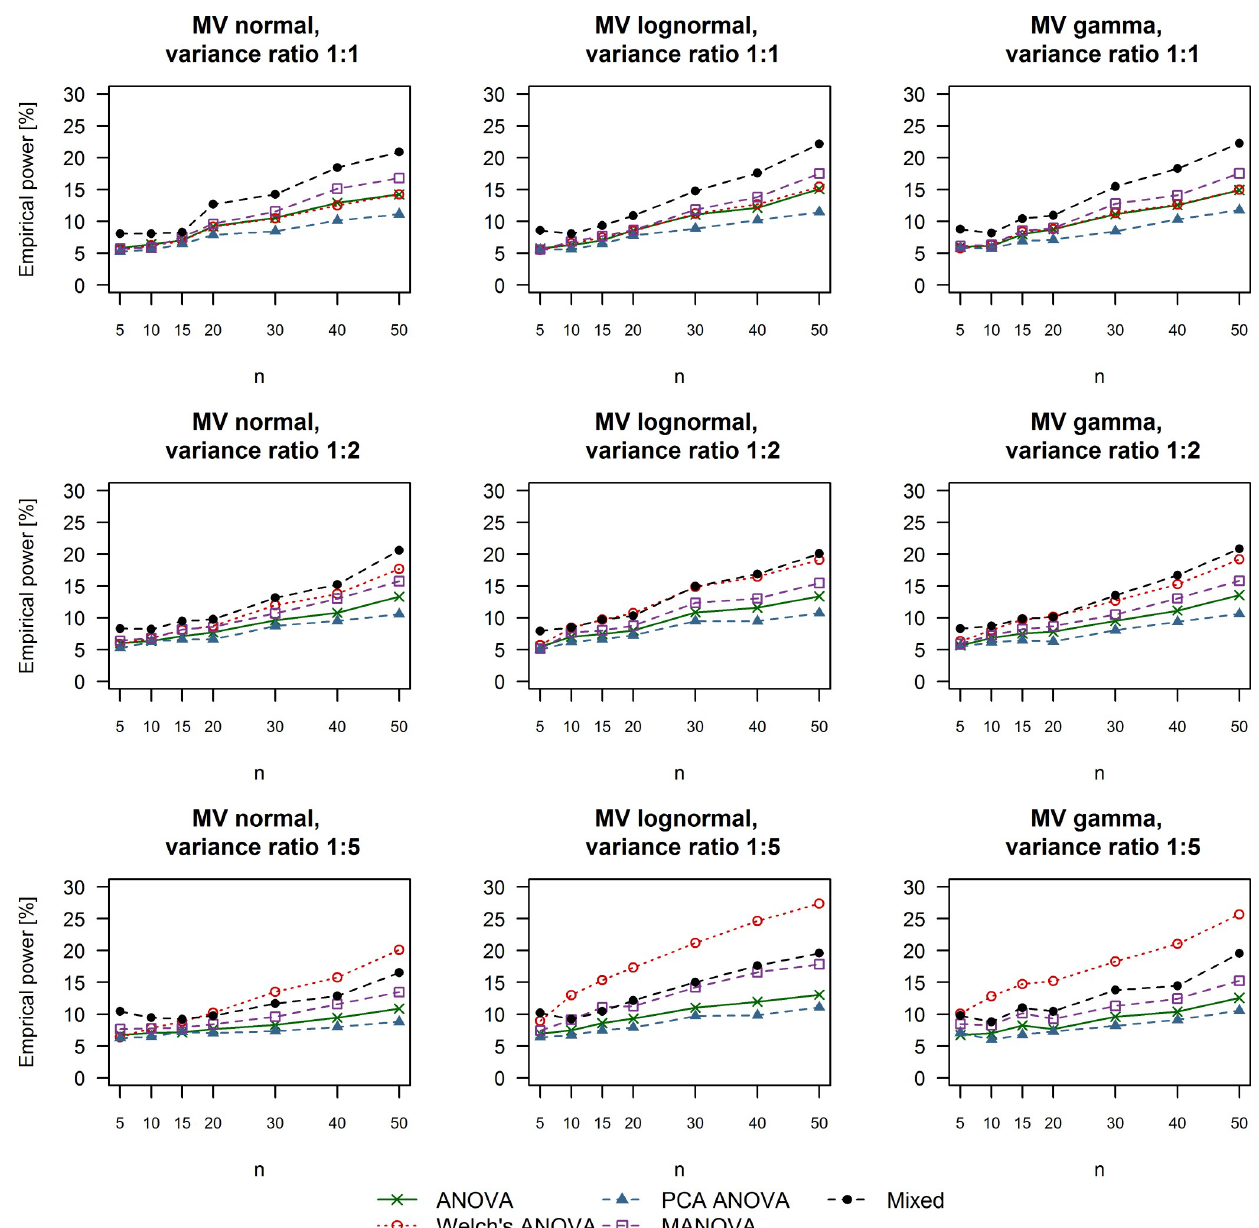
Fig 5. Empirical power of univariate and multivariate techniques in case of small treatment effects (Cohen’s d equal to 0.2). The multivariate distribution from which the data were drawn as well as the variance ratio between simulated control and treatment groups are summarized in the title of each respective plot. ANOVA: Analysis of variance; MANOVA: Multivariate analysis of variance; Mixed: Linear mixed effects model; MV: Multivariate; PCA: Principal component analysis. simulated treatment effects were 20-point neuroscore on day 1 and day 7, limb placing score on day 1 and day 7, lesion volume on day 1 and day 7, edema volume on day 1 and day 14 and T2 lesion in the contralateral cortex on day 1. The remaining 9 variables were drawn from the same distributions in the control and the 3 treatment groups without simulated treatment effects.